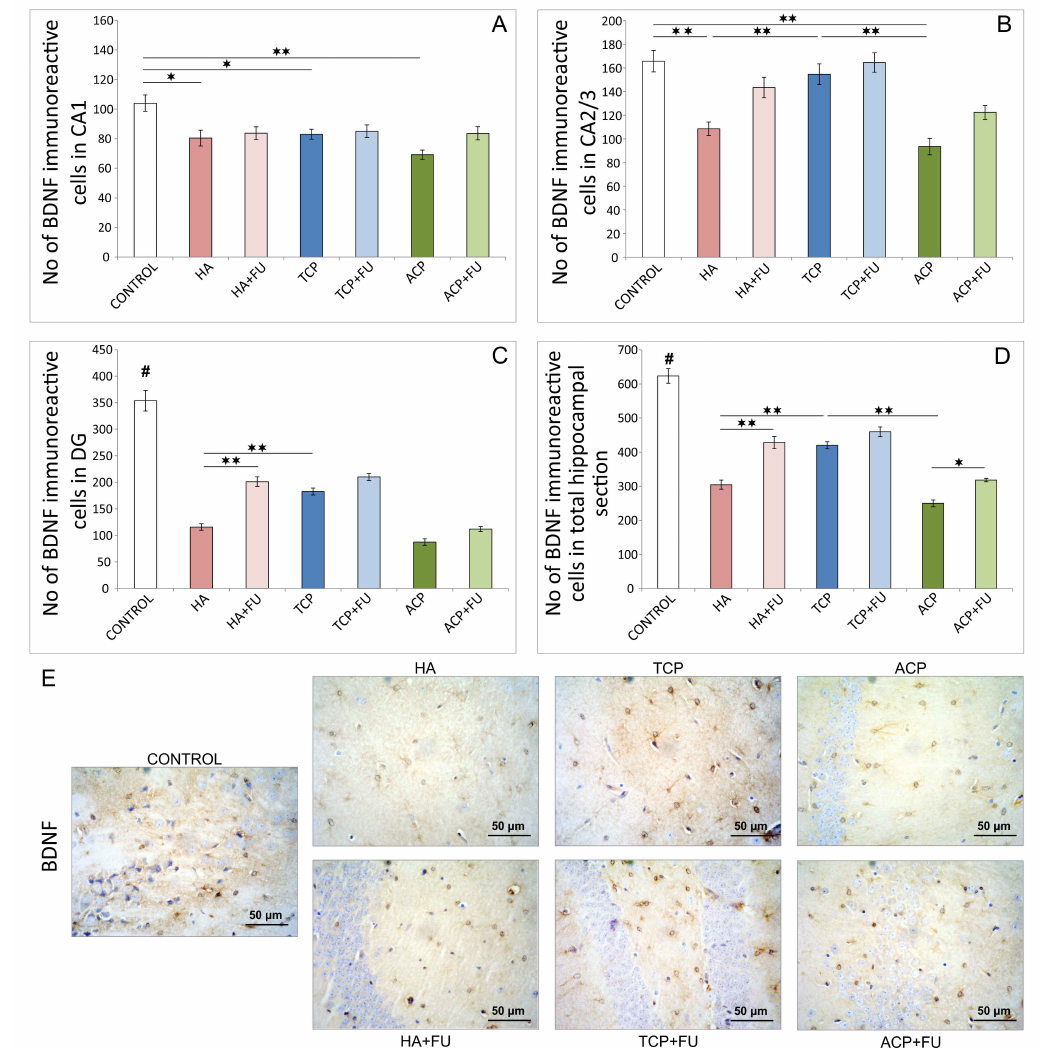
Fig. 5. Quantitative immunohistochemical analysis of BDNF-positive cells in the hippocampus (6 per group) and the distribution in CA1 region (A), CA2/3 region (B), DG (C), and the total section of the hippocampus (D), and (E) the representative images of BDNF IHC staining (original magnification × 40). HA – hydroxyapatite; HA + FU – hydroxyapatite and Filipendula ulmaria extract; TCP – tricalcium phosphate hydrate; TCP + FU – tricalcium phosphate hydrate and Filipendula ulmaria extract; ACP – amorphous calcium phosphate; ACP + FU – amorphous calcium phosphate and Filipendula ulmaria extract. The graph bars present mean ± SEM, * represents a significant difference p < 0.05, ** represents a significant difference p < 0.01, # represents a significant difference ( p < 0.01) between control and all other